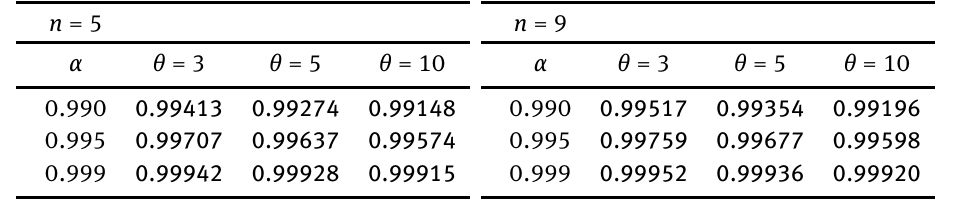
Table 5 Values for α * for a n -dimensional Gaussian copula C Ga ρ .